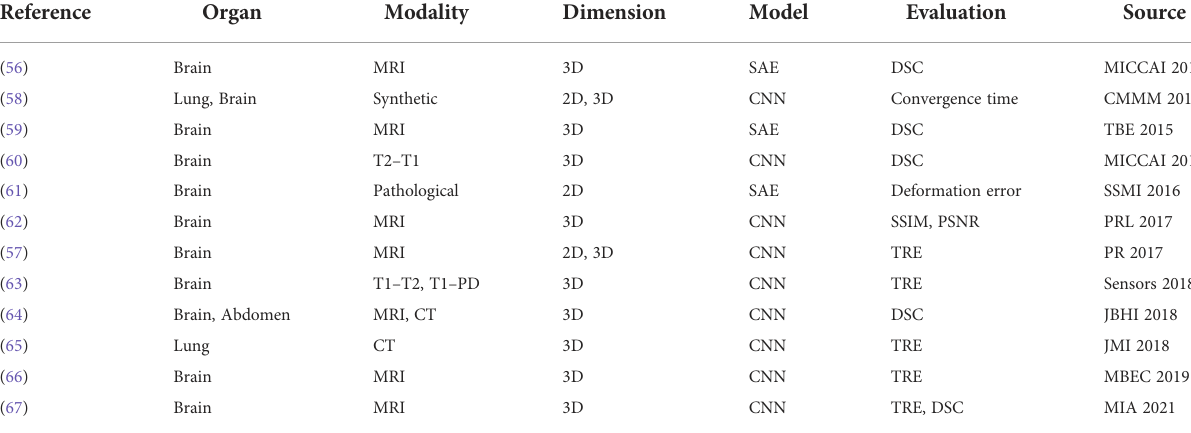
TABLE 2 Medical image registration methods based on deep similarity metrics.